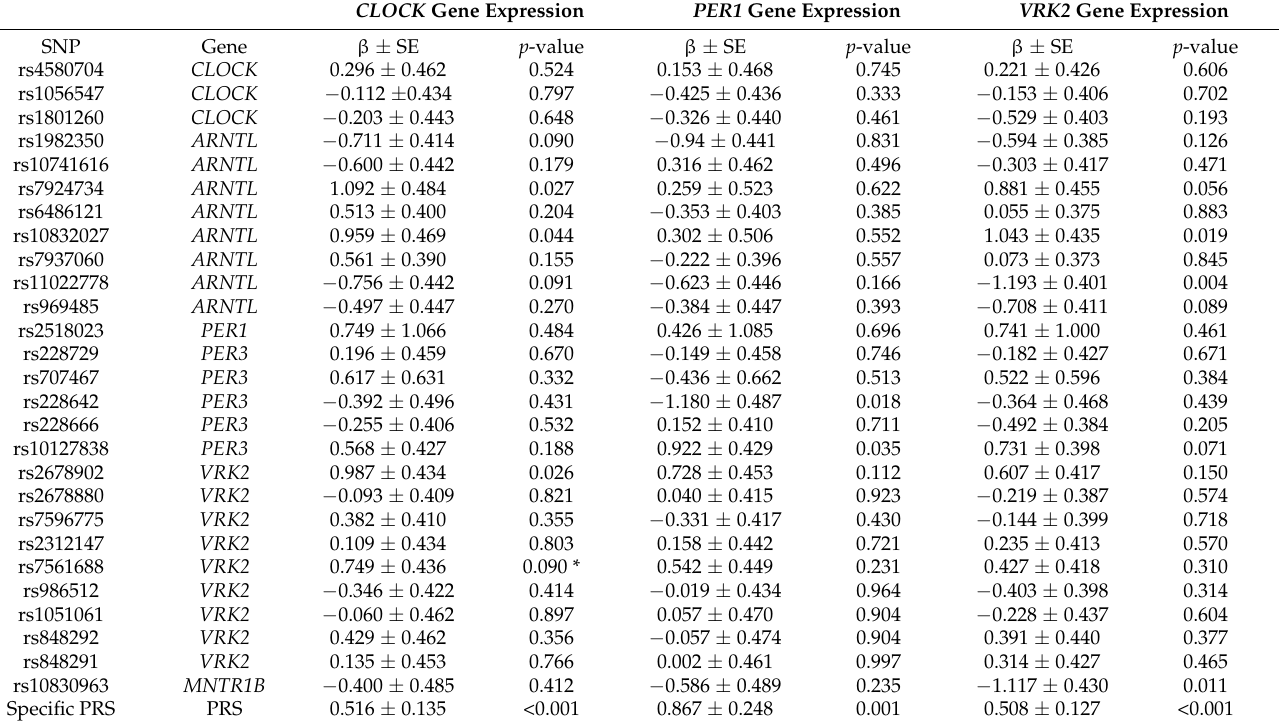
Table 2. Relationship between clock gene polymorphisms and clock gene